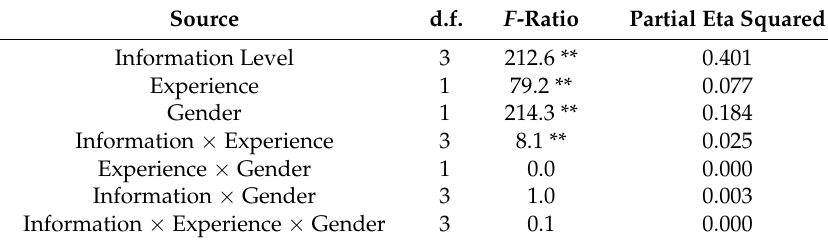
Table 9. Analysis of variance results for lane